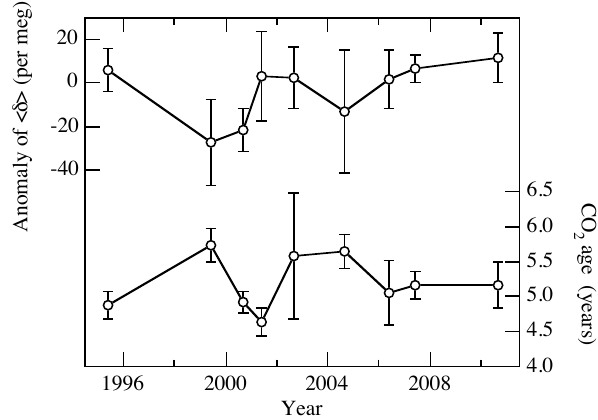
Figure 5. Average values of the deviations of < δ > from its mean vertical profile over the 2 Fig. 5. Average values of the deviations of <δ > from its mean observation period (upper) and those of the CO 2 ages (lower) at heights above 20-28 km 3 vertical profile over the observation period (upper) and those of for the respective years. 4 the CO 2 ages (lower) at heights above 20–28km for the respective 5